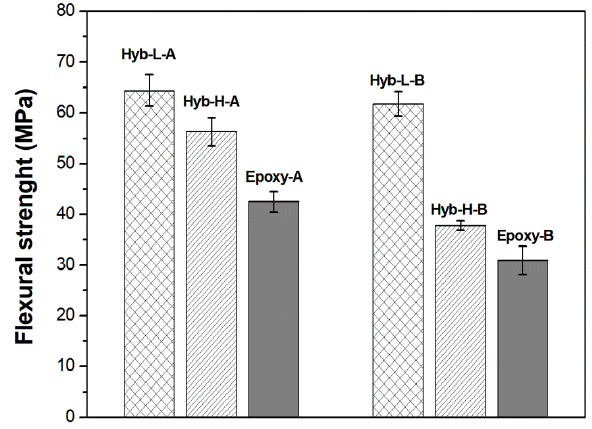
Figure 11. Flexural modulus of hybrid and non-hybrid epoxy systems.